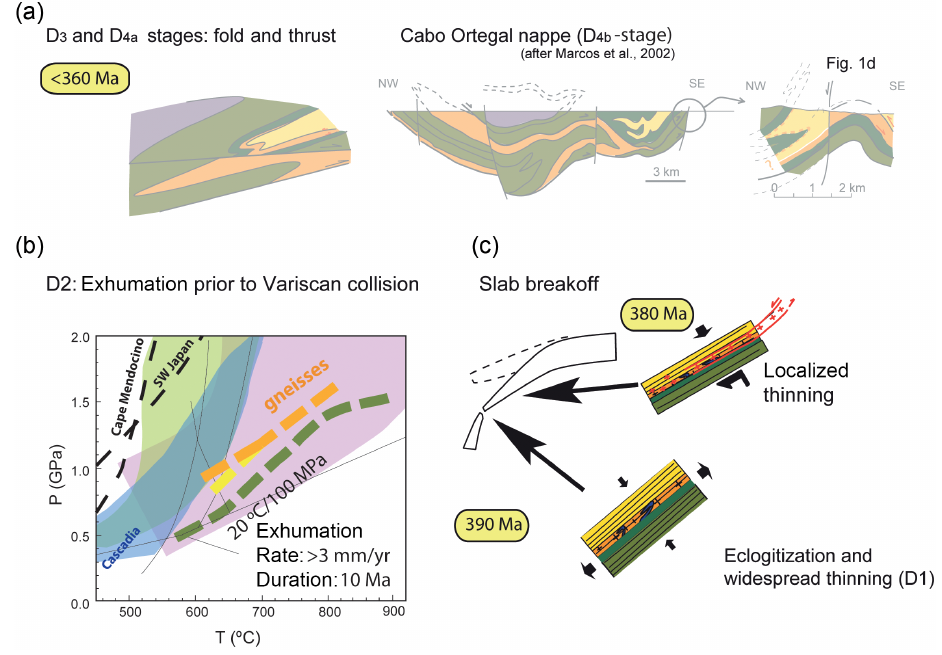
Figure 16. Synthetic tectonic evolution of qz-fsp gneisses within the Cabo Ortegal nappe. (a) Simplified geological section of the Cabo Ortegal nappe at present, showing the detail of the structure in the Masanteo peninsula (cross section in Fig. 1d, modified from Marcos et al., 2002). Partially restored section to the left shows the relationships between D 3 -recumbent folds and D 4a -thrust. (b) D 2 -stage (390–380Ma) summarising the effect of progressive localization of deformation and thinning during exhumation. The P–T diagram (based on Fig. 5) is showing the retrograde P–T-t paths for migmatites, metasedimentary qz-fsp gneisses and mafic granulites compared to current subduction zones. (c) Slab breakoff could eclogitize the top of the mafic granulites during a widespread thinning of the tectonic sequence (Llana-Fúnez et al., 2004). (d) A Cambro-Ordovician melting event led to the injection of felsic dykes at the base of the qz-fsp gneisses coeval with leucosome in the mafic granulites (Fernandez-Suarez et al., 2002). Arrows indicate the inferred finite strain principal